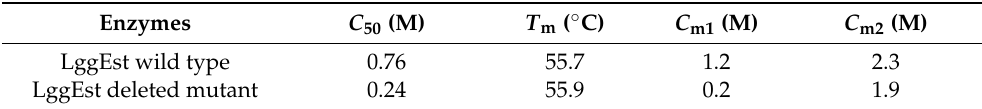
Table 2. Thermodynamic parameters for enzyme inactivation and protein unfolding of LggEst wild type and the deleted mutant.